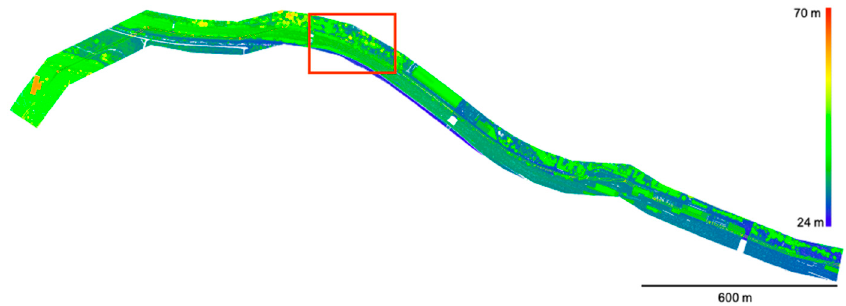
Figure 7. The training and test data used in this study. The red rectangle indicates the test area where we never used in the and parameter tuning process. The colors represent height values of the points from 24 m to 70 m.